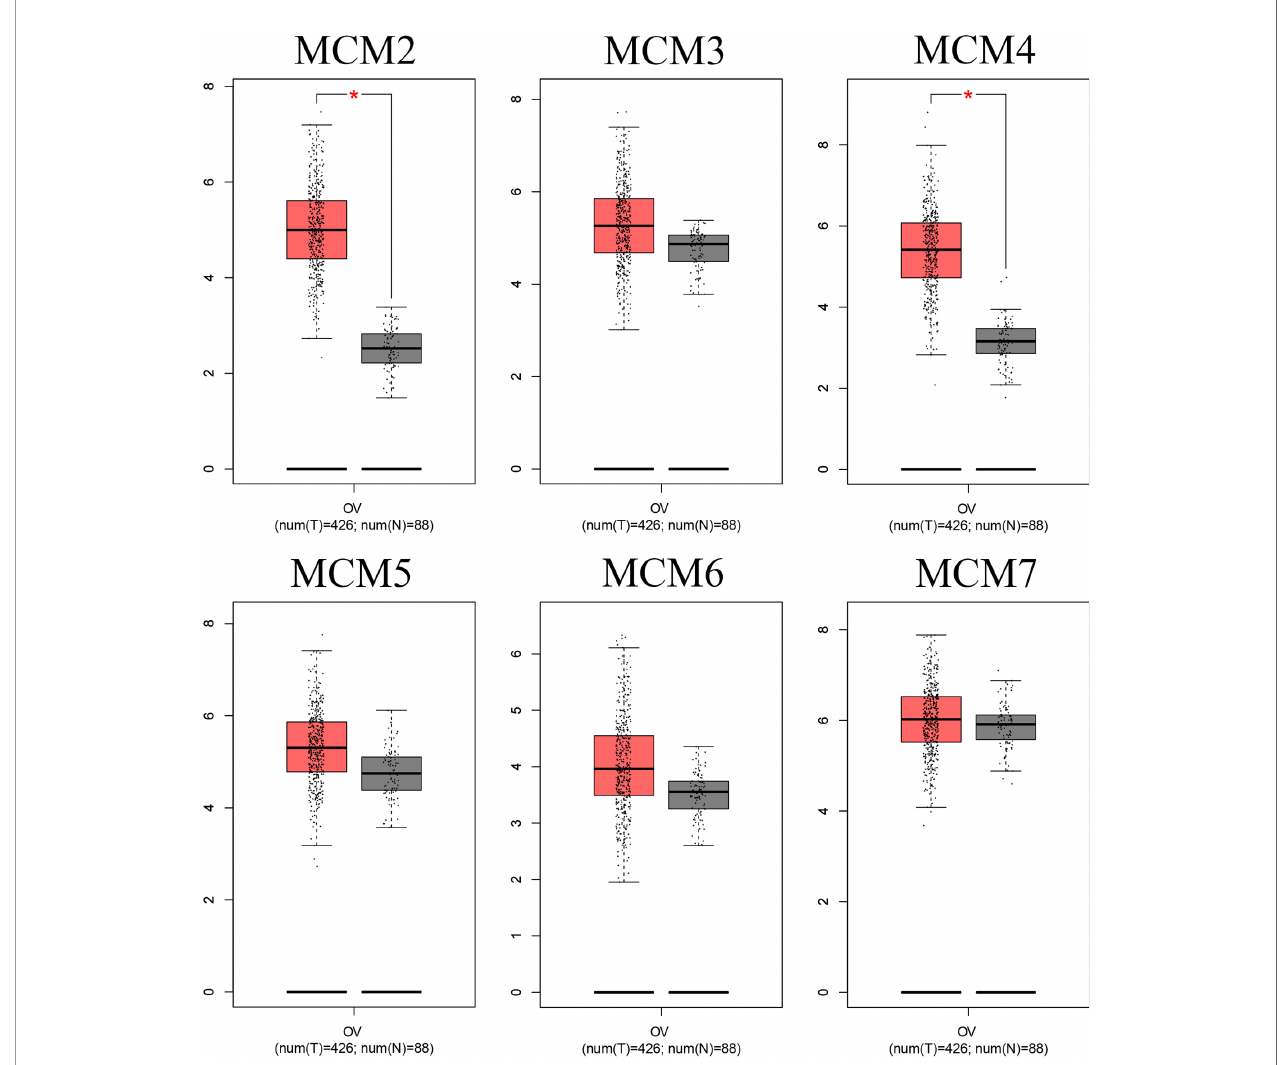
FIGURE 3 | mRNA level of the MCMs in OC. The mRNA level of the MCM complex in OC compared to that in normal ovary tissues based on the GEPIA database. *p <